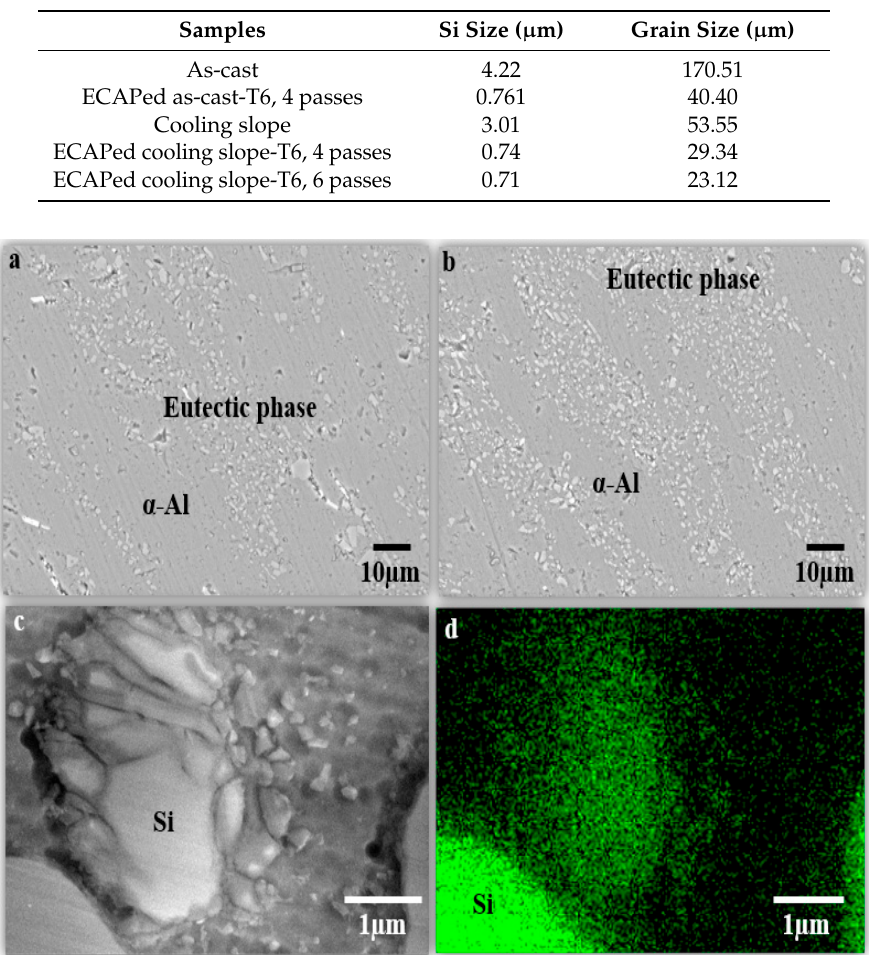
Figure 5. FESEM images: Si particles morphology after ECAP ( a ) as-cast, ( b ) cooling slope, ( c ) and ( d ) SEM and mapping of Si fragmentation of ECAPed sample.